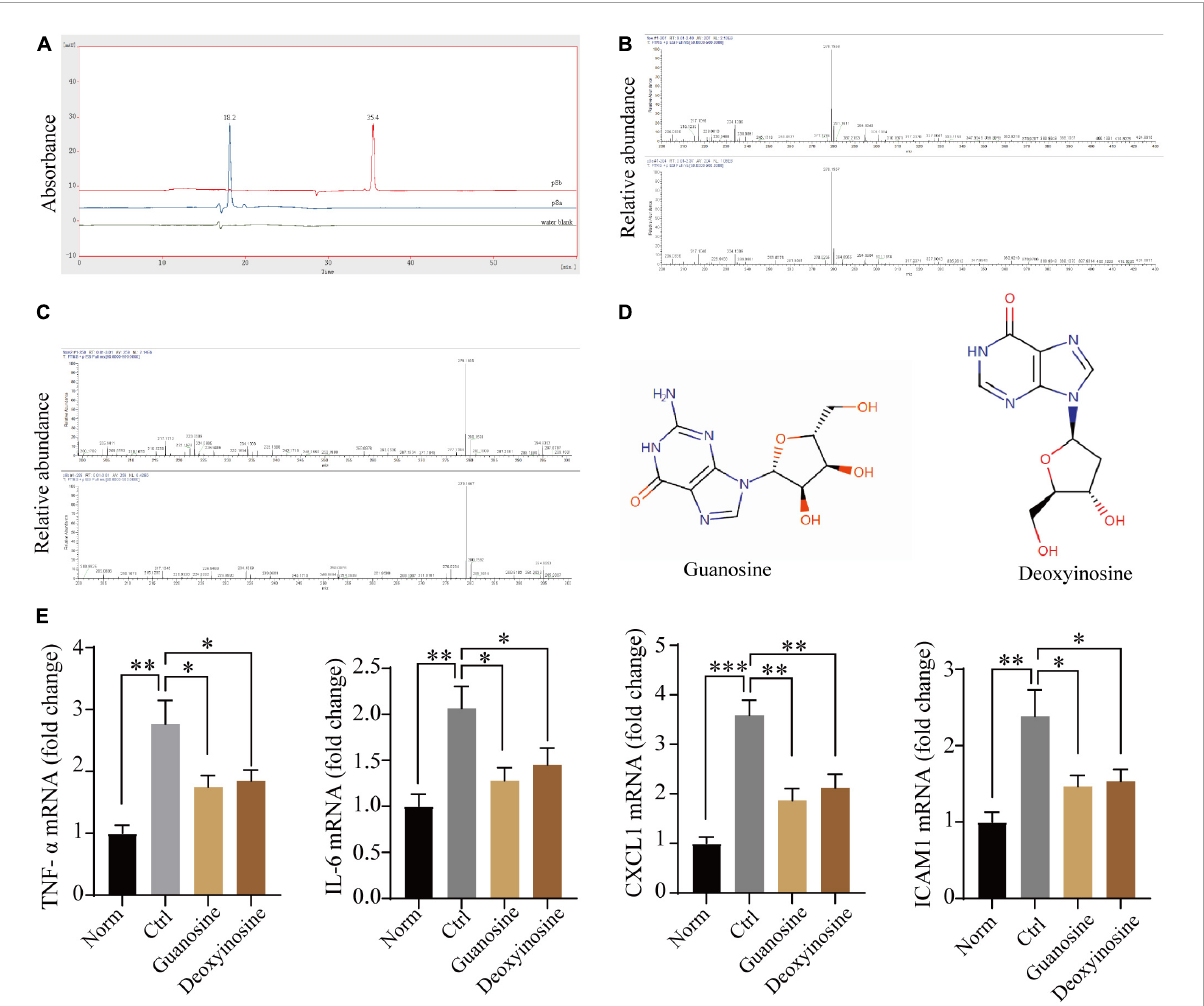
FIGURE7 Mass spectrometric analysis of P8. (A) P8 showed two main peaks (P8a and P8b) on the Agilent Zorbax AQ column (rt: 12.113;13.627). (B–D) Mass spectrometry analysis revealed that guanosine and deoxynucleoside were the main components of Peak 8. (E) Transcriptome expression of inflammatory genes in human cardiac cell line AC16 after hypoxia – reoxygenation treatment, with or without Guanosine or deoxyadenosine ( µ mol/L) by real-time PCR ( n = 3). * p < 0.05; ** p < 0.01; *** p <